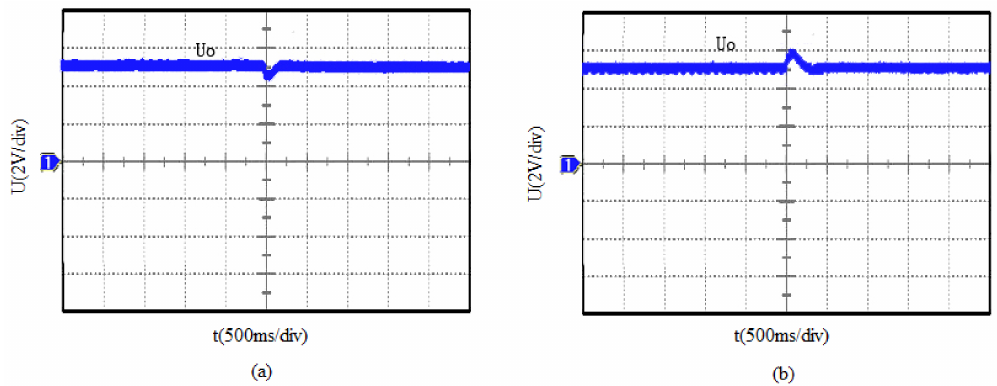
Figure 26. Output voltage waveforms of load mutation: ( a ) load increases; ( b ) load